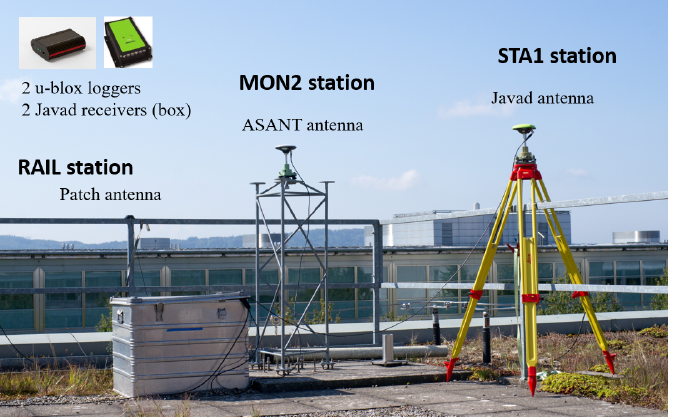
Figure 4. Session 2: experimental setup for station “RAIL”, “MON2” and “STA1” for the static kinematic tests, located at the roof of ETH HPV building.